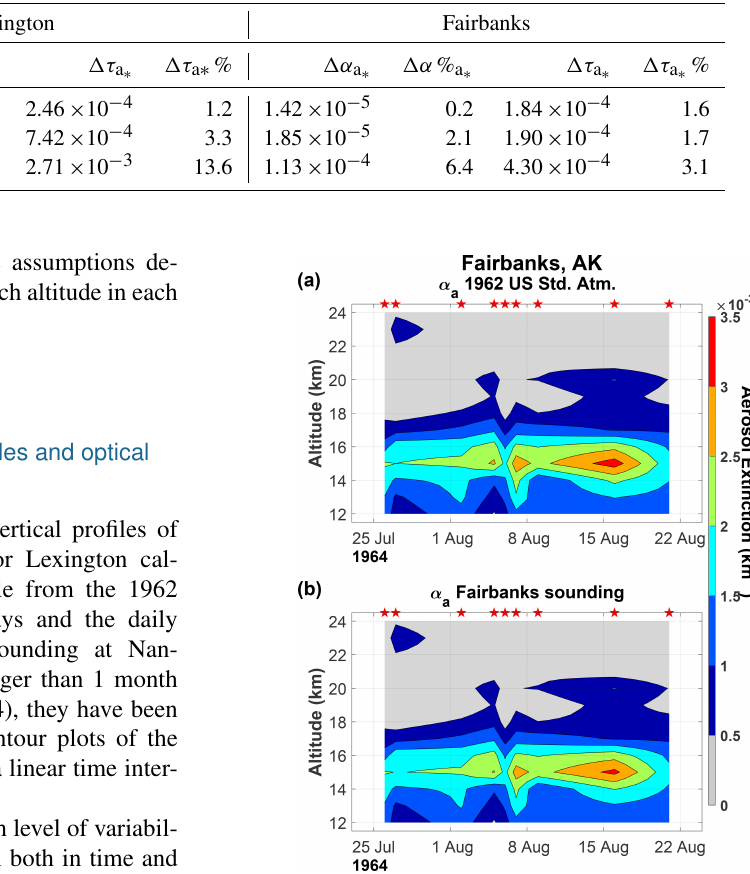
Table 2. Relative differences between the α a